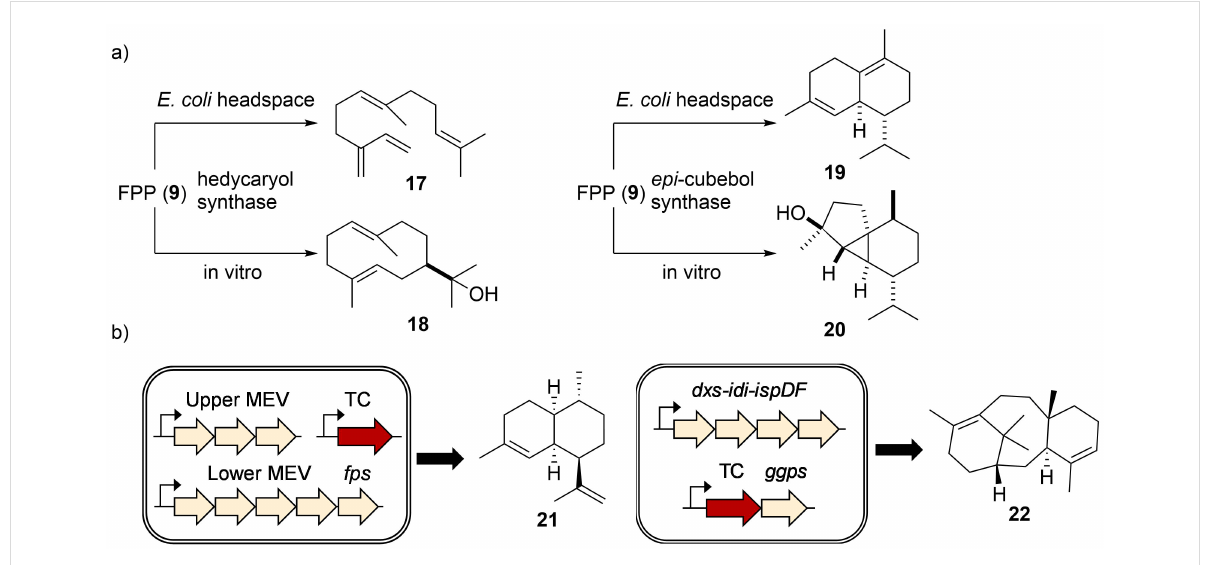
Figure 6: Functional TC characterization. a) Different terpenes were produced when hedycaryol ( 18 ) synthase and epi -cubebol ( 20 ) synthase were expressed in E. coli vs incubated with FPP ( 9 ) in vitro. b) Engineering the isoprenoid flux increases the titer of terpene